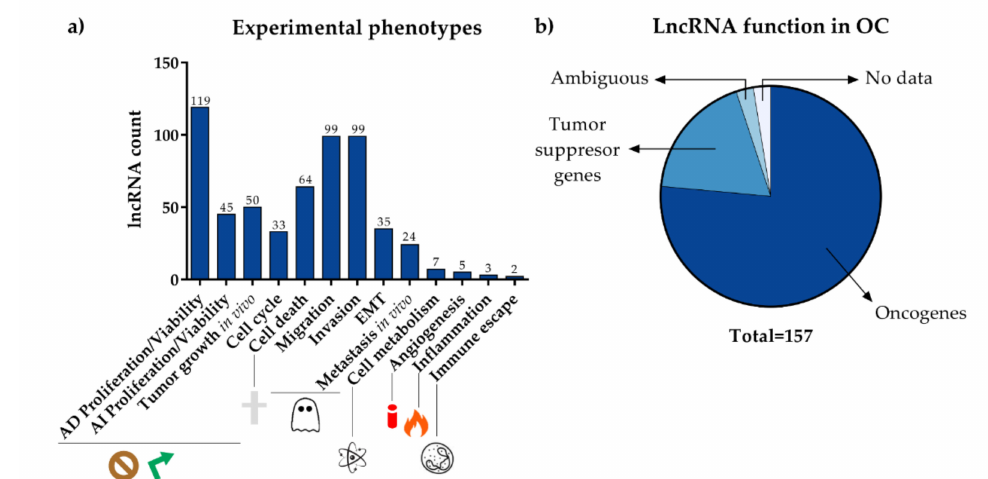
Figure 2. Summary of the functional implications of lncRNAs based on experimental evidence. ( a ) Number of lncRNAs contributing to the indicated phenotype or cancer hallmark; ( b ) Proportion of lncRNAs according to their net e ff ect on ovarian cancer onset, development, and progression. AI: anchor-independent; AD: